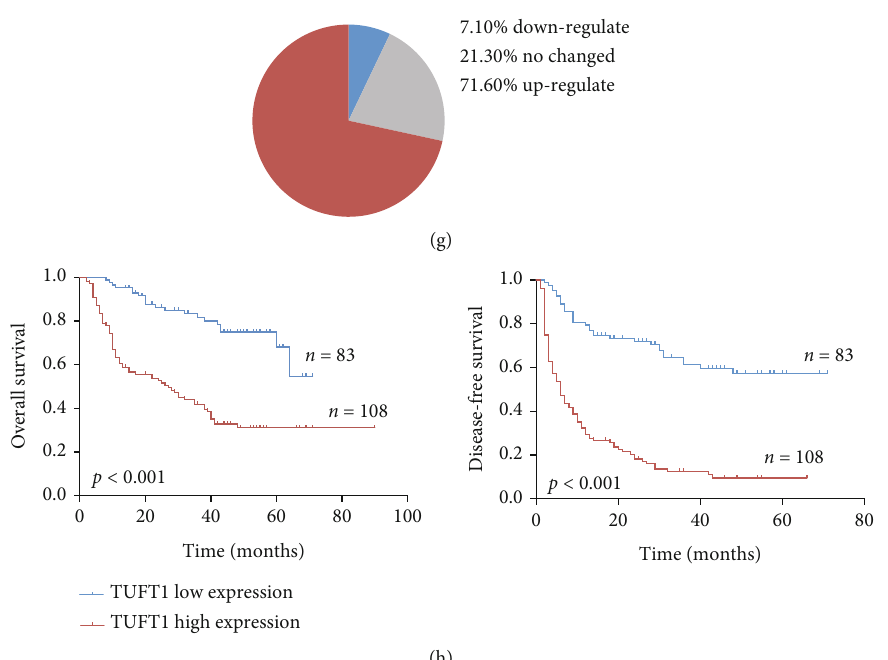
Figure 1: Expression of TUFT1 and its correlation with patients ’ survival in HCC. (a and b) Analysis of the expression of TUFT1 in HCC and corresponding normal tissue using three independent GEO datasets (GSE6764, GSE14520, and GSE54238). (c) Correlation analysis of TUFT1 expression and copy number alteration using TCGA database. (d and e) Relative mRNA (d) and protein (e) level of TUFT1 in HCC and corresponding normal livers. (f) Representative images of IHC staining of TUFT1 in the HCC tissue microarray (scale bar: 200 μ m). (g) Pie chart showing the percentage of cases with di ff erent TUFT1 expression pro fi les in comparison with CNL. (h) Kaplan-Meier survival analysis of patients with high or low TUFT1 expression, using TMA1 from Renji Hospital (Renji